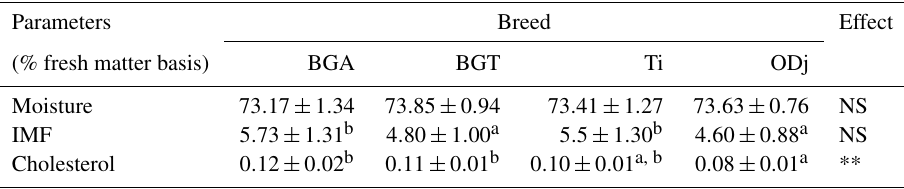
Values in the same row with different superscripts are significantly ( p < 0 . 05 ) different. NS: not significant; ∗ p < 0 . 05 ; ∗∗ p < 0 . 01 ; ∗∗∗ p < 0 . 001 ; BGA: female lambs of Beni Guil breed sampled in the Ain Beni Mathar region; BGT: female lambs of Beni Guil breed sampled in the Tendrera region. Table 2. Fatty acid profiles of Beni Guil (BG), Timahdite (Ti), and Ouled Djellal (ODj) sheep meats from Moroccan pastures.